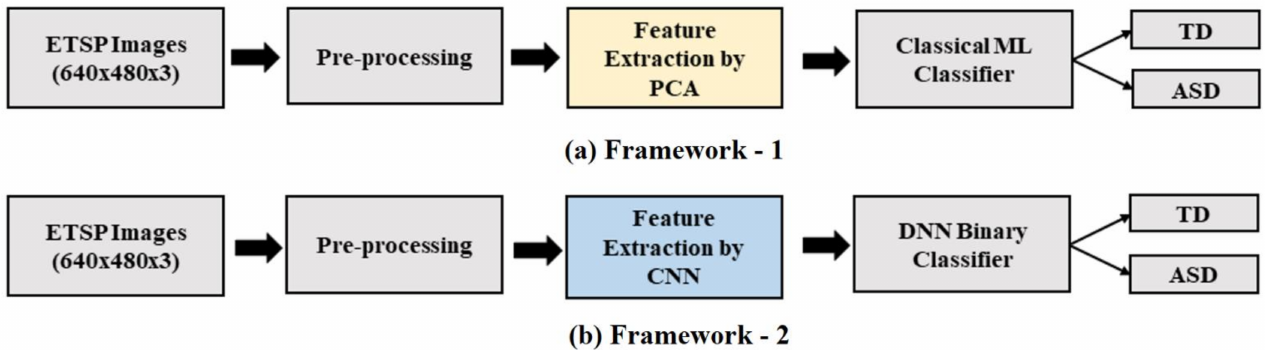
Figure 2. The framework of the proposed